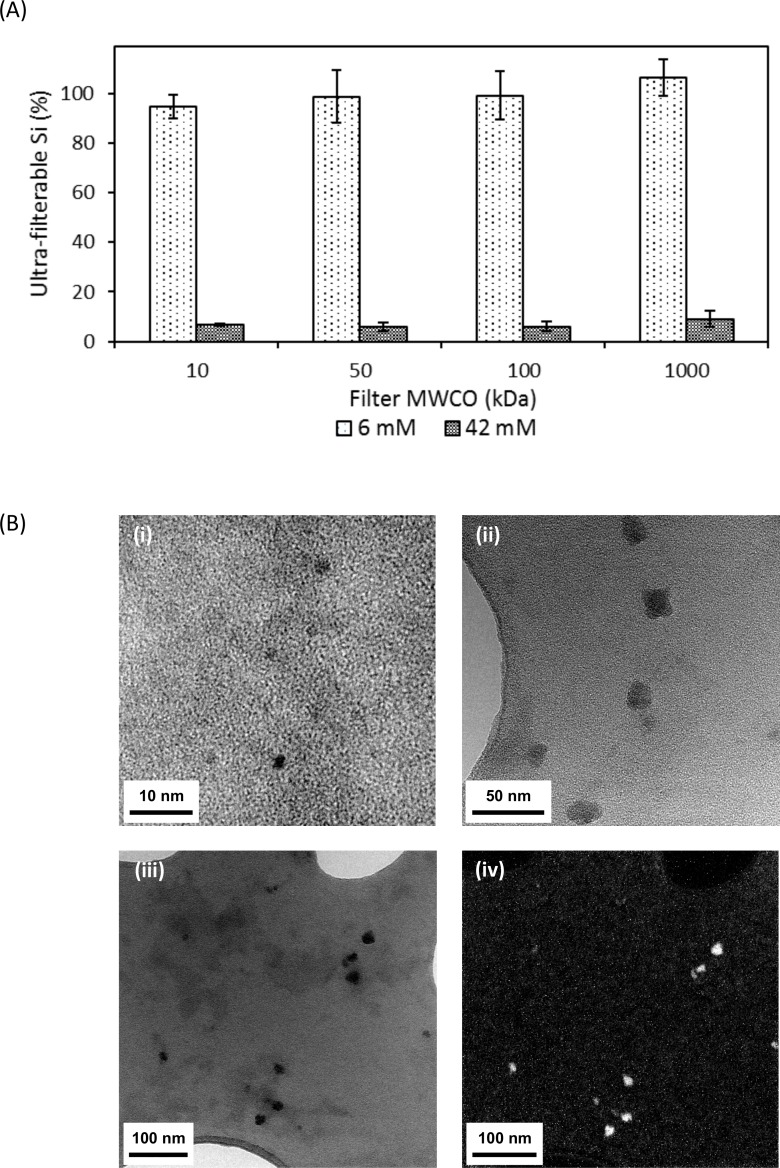
(A) Percentage of total silica in 6 and 42 mM silica dispersions that passed through 10, 50 100 and 1000 kDa MWCO (molecular weight cut-off) membranes. (B) TEM analysis of the filtrates. i) TEM of amorphous nanoscale silica particles (NSP) in the filtrate of the 10 kDa MWCO filtered 6 mM silica dispersion; ii) TEM showing larger (< 20 nm) NSP in the filtrate of the filtered 42 mM silica dispersion; iii) Bright field, zero loss filtered TEM image of NSP in the filtrate of the filtered 42 mM dispersion and iv) EF-TEM Si L2,3 elemental map image of NSP shown in (iii). The bright regions indicate Si-rich areas.